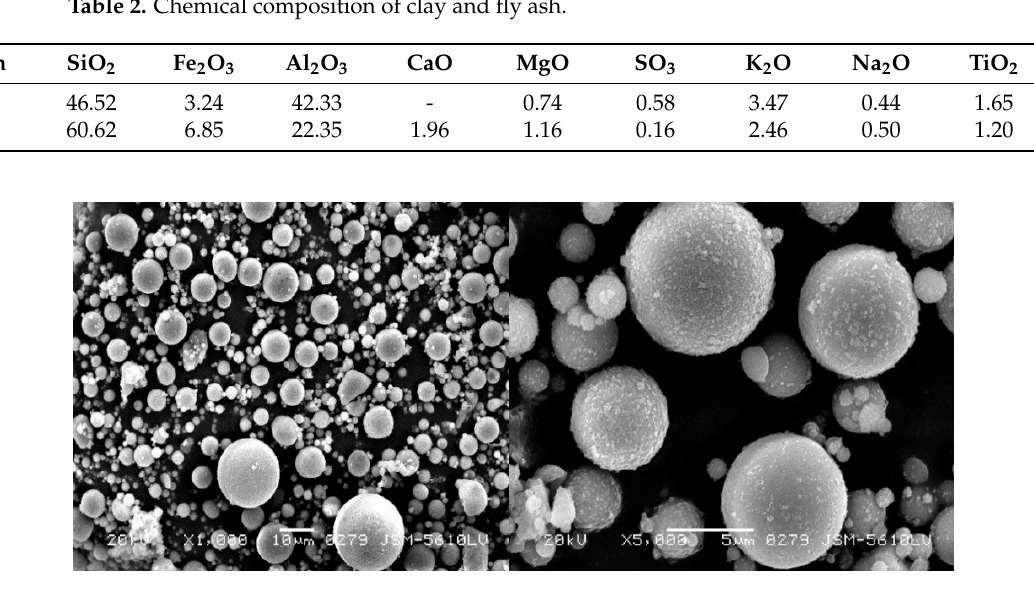
Table 2. Chemical composition of clay and fly ash.